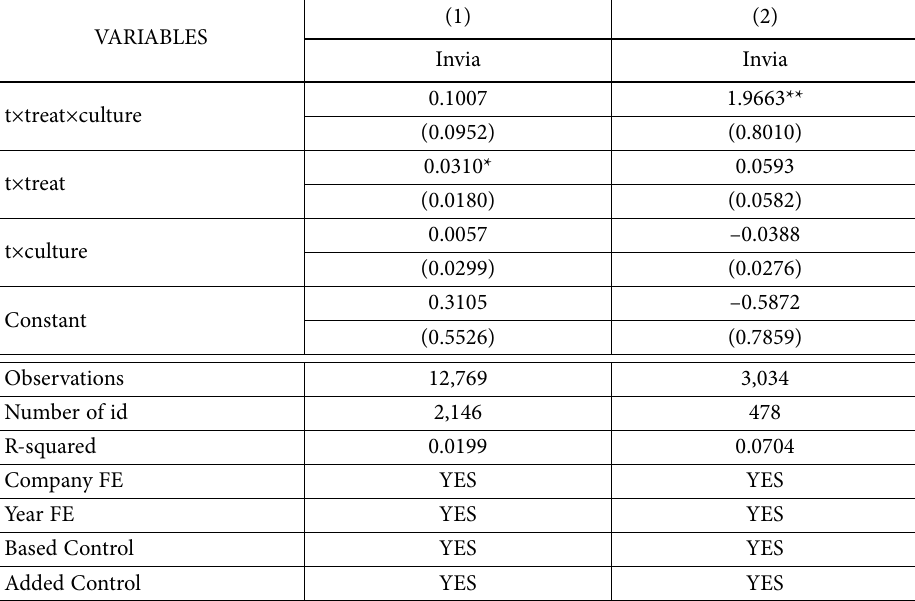
Table 10. High-tech and non-high-tech